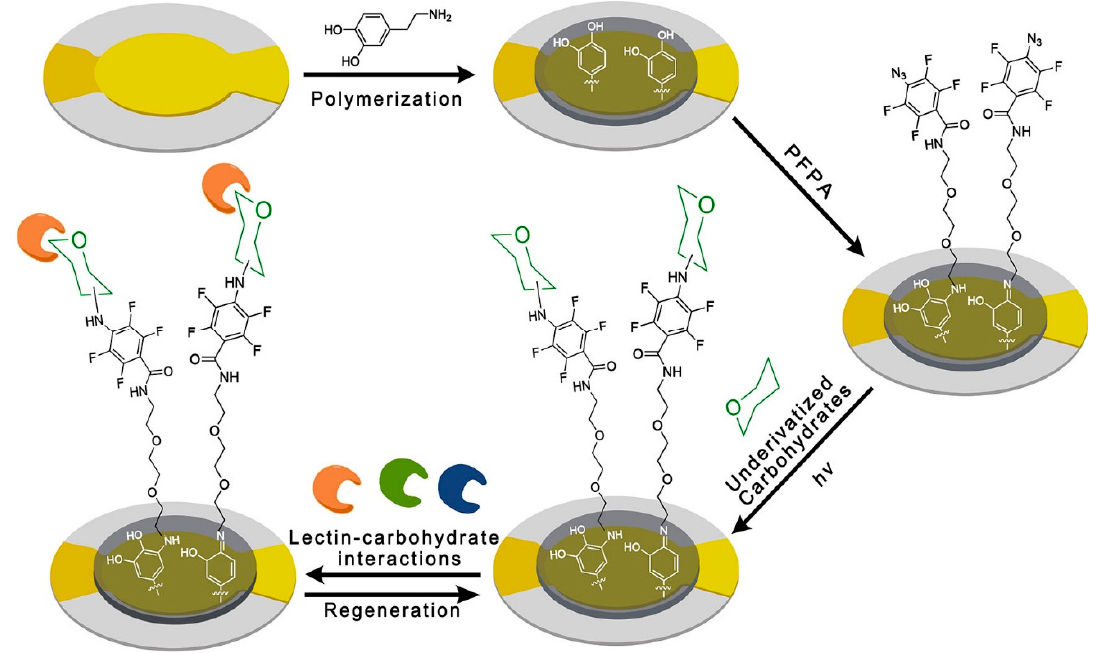
Figure 2. Schematic illustration of preparing the carbohydrate sensor, based on the universal method.